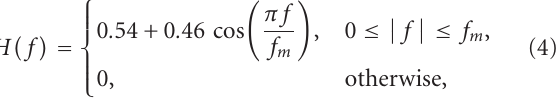
Figure 3: Butterworth smoothing filter six curves by di ff erent n parameters (equation (2)). A, B, C curves created by f c and critical frequency f c = 0 . 1 c/pixel and order n equal to 2, 8, 32 correspondingly. D, E, F curves created by critical frequency f c = 0 . 3c/pixel and order n equal to 2, 8, 32 similarly [6].